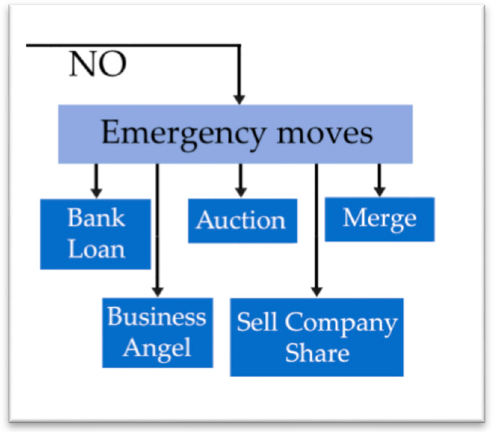
Figure 5. Emergency moves